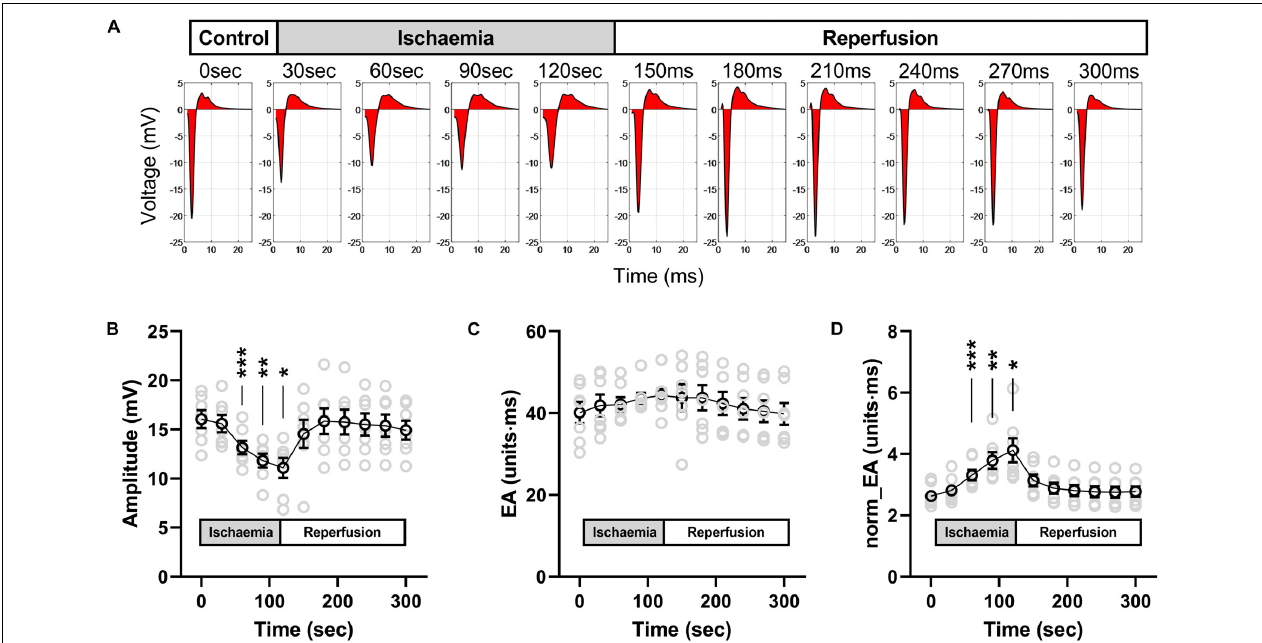
FIGURE 9 | Effects of low-flow ischemia on electrogram morphology in isolated mouse hearts. Changes in electrogram morphology during low-flow global ischemia in perfused mouse hearts. (A) Representative bipolar electrogram recordings showing the change in electrogram morphology during a 120-s period of low-flow ischemia and subsequent tissue reperfusion in a single mouse heart. The red shading indicates the calculated electrogram area. (B–D) Mean data from seven mouse hearts showing the changes in bipolar electrogram amplitude (B) , absolute electrogram area (EA) (C) , and amplitude-normalized EA (norm_EA) (D) in response to ischemia-reperfusion. Different from 0; * p < 0.05, ** p < 0.01, *** p < 0.001. Data are mean ± SEM. Actual replicates are shown in gray. n = 7 hearts.